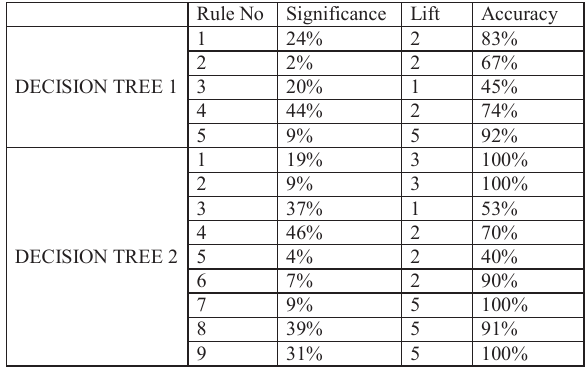
Table7. Extracted rule evaluation from Stage 2